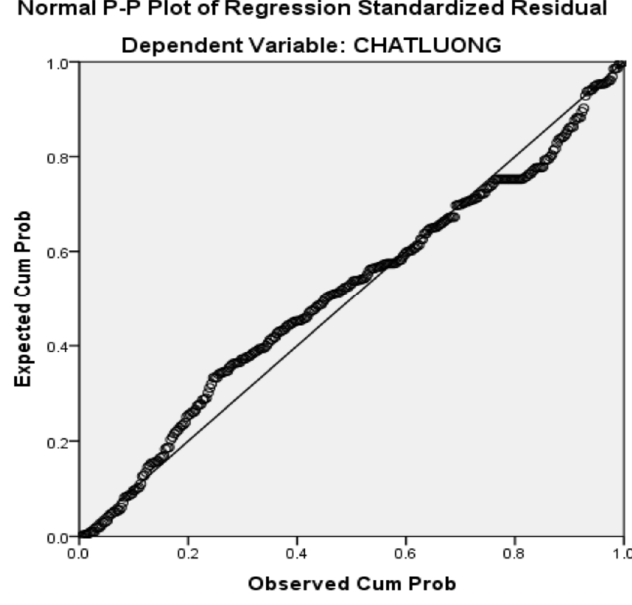
Figure 4. Normal P–P plot of regression standardized residual.